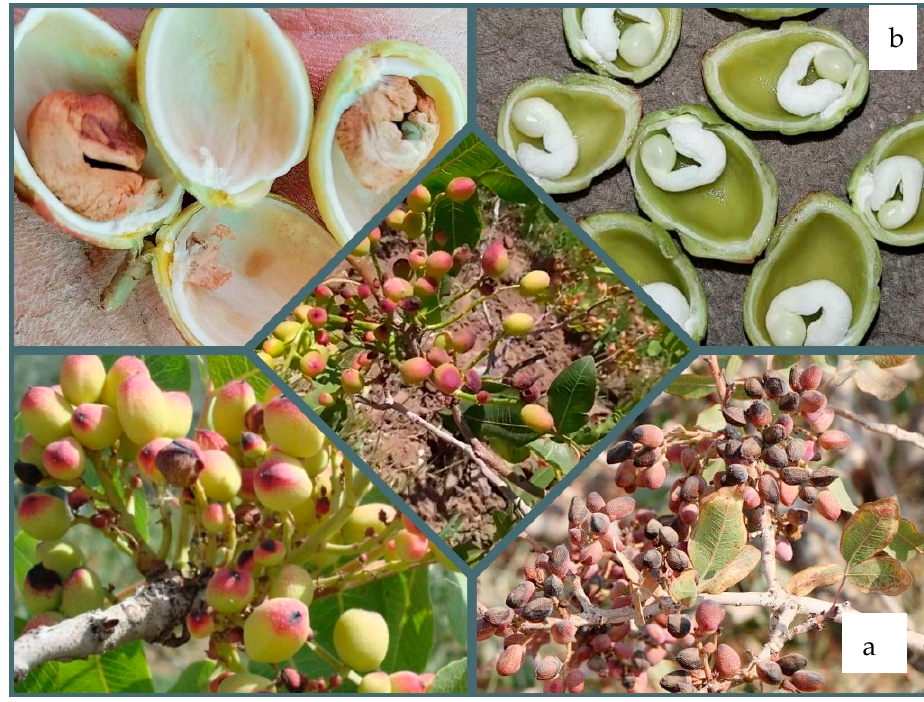
Figure 2. ( a ) Effect of sunburn on pistachio fruit on necrotic black color, and ( b ) abortion of pistachio kernels due to sunburn.